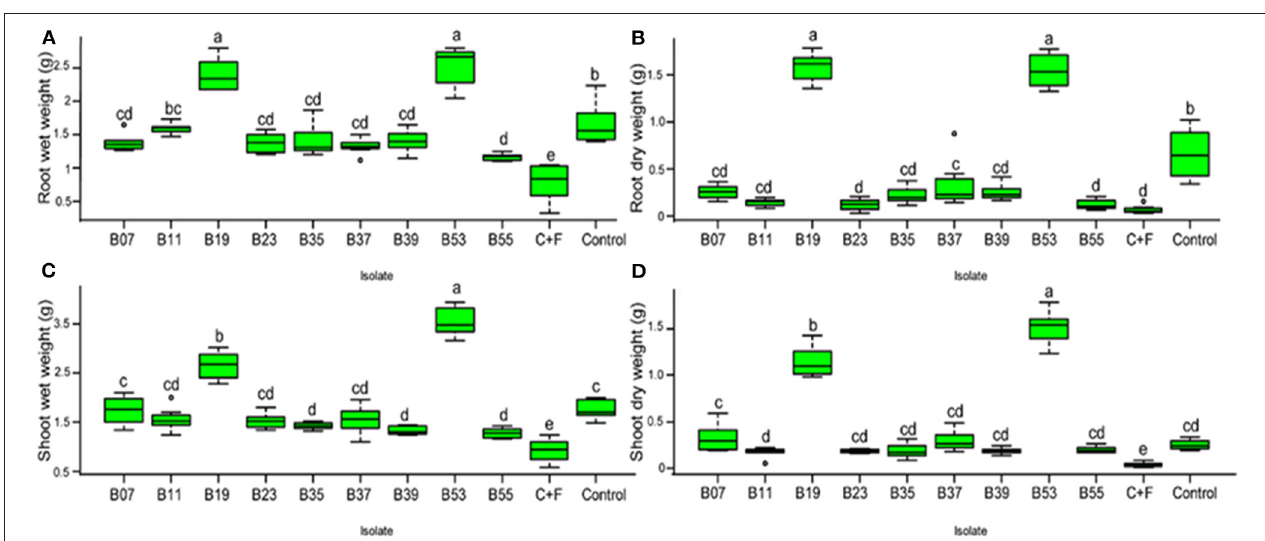
FIGURE 6 | (A–D) Box plot represent the effect of bacterial endophytic inoculation on bean seedlings in the presence of Fusarium solani on the fresh and dry weights of the roots t and shoot. C + F represents a control with the growth of seedlings without endophyte in the presence of fungal pathogen while control represents seedling growth without pathogen or endophyte in a sterilized soil. Bars represent SE of the mean. Treatments with different letters are significantly different from each other (ANOVA test followed by SNK’s post-hoc test, P < 0.05).